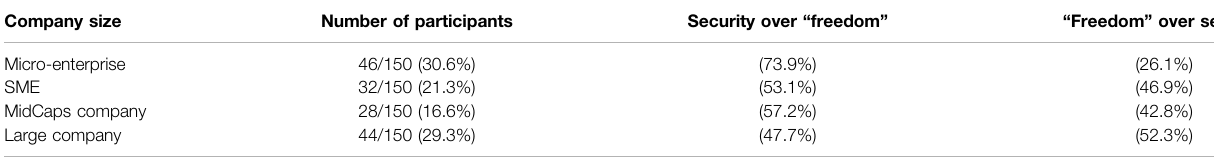
TABLE 11 | Correlation between the perception of mechanisms and the size of the companies. Company size